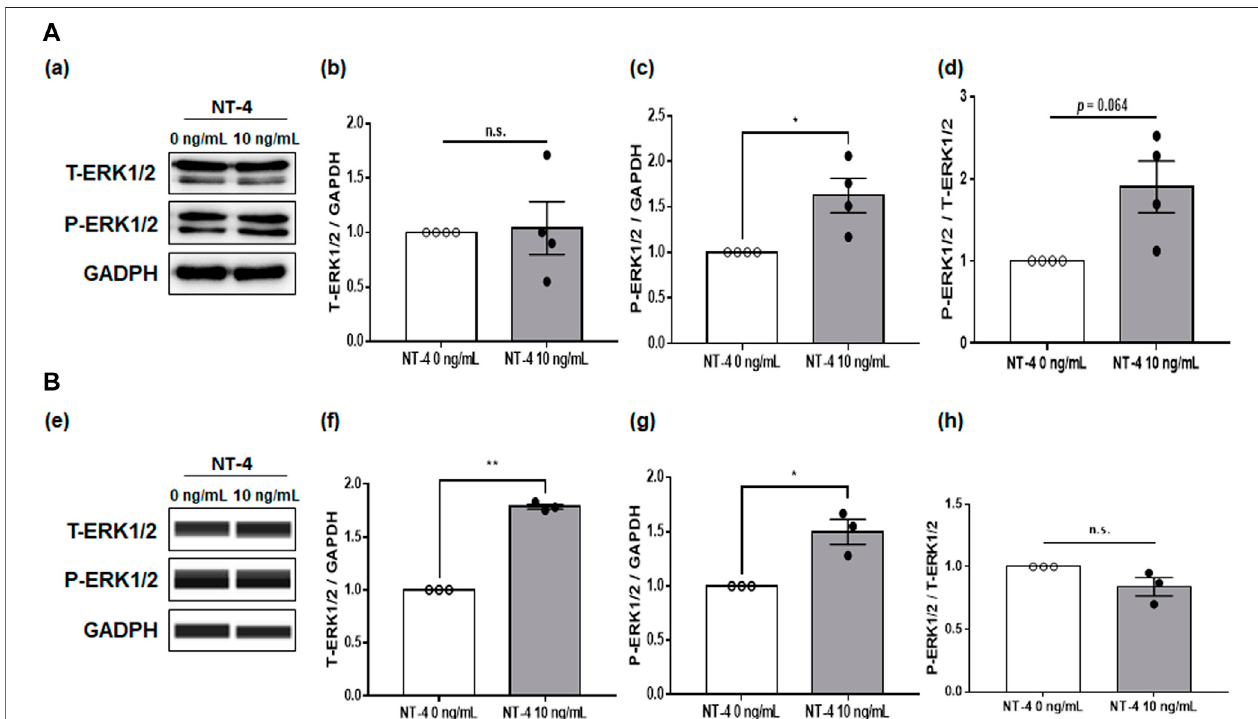
FIGURE 4 | Expression and phosphorylation levels of extracellular signal-regulated kinase 1/2 (ERK1/2) in porcine cumulus cells (CCs) and oocytes after in vitro maturation (IVM). (A,B) Western blots of total ERK1/2 (T-ERK1/2), phosphorylated ERK1/2 (P-ERK1/2), and GAPDH in CCs (A) and oocytes (B) . The levels of T-ERK1/ 2 (b, f) and P-ERK1/2 (c, g) and the ratio ofP-ERK1/2 to T-ERK1/2 (d, h) in CCs (a) and oocytes (e) . The results were normalized to thoseof GAPDH. Values represent the mean ± SEM. The experiment was replicated at least three times. * p < 0.05 and ** p < 0.01 (Student ’ s t-test). n.s. indicates not signi fi cant (p > 0.05).